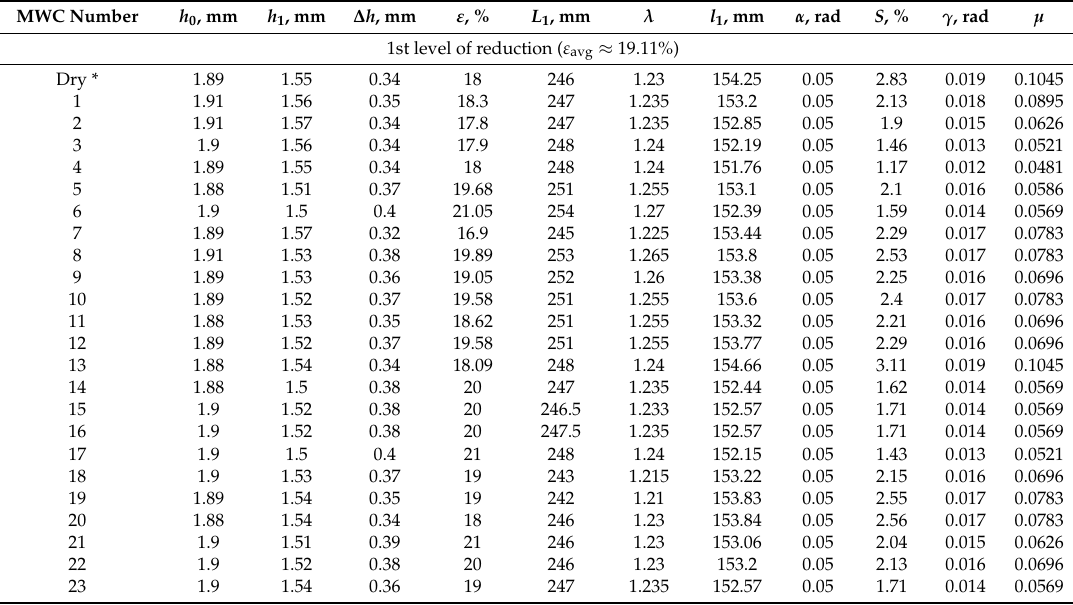
Table 4. Experimental data of 08Kp steel cold rolling with various MWC. ( L 0 = 200 mm, l b = 150 mm, D f = 260